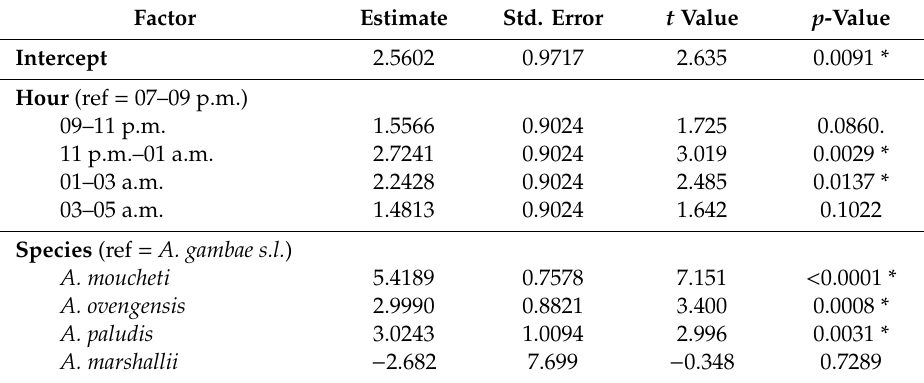
Table 3. ANOVA model of human biting rates as a function of di ff erent time slots and species. Factor Estimate Std. Error t Value p -Value Intercept 2.5602 0.9717 2.635 Hour (ref = 07–09 p.m.)